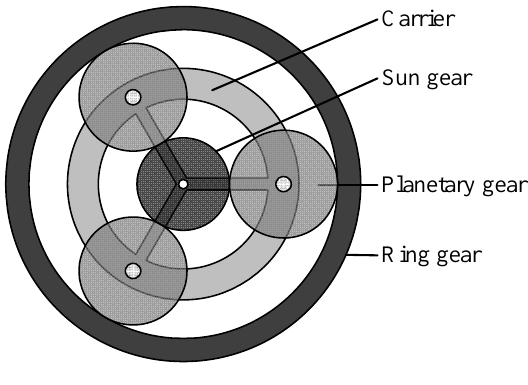
Figure 4: Typical planetary gear with three planets.